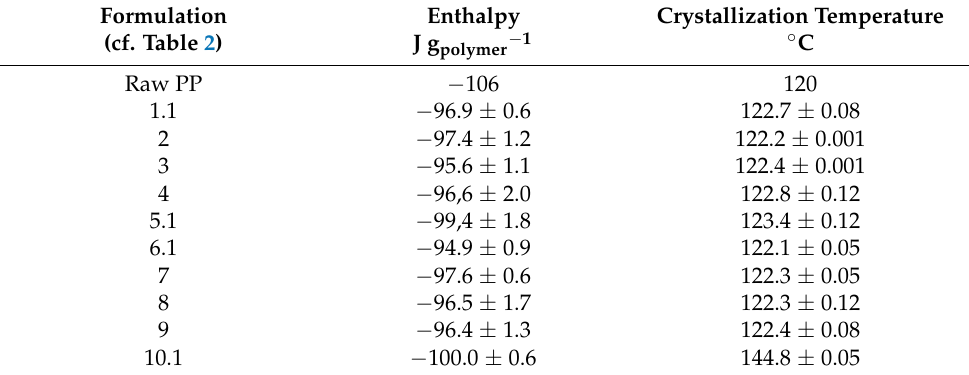
Table 3. Measured values of the degree of the thermal analysis. Formulation (cf. Table 2)